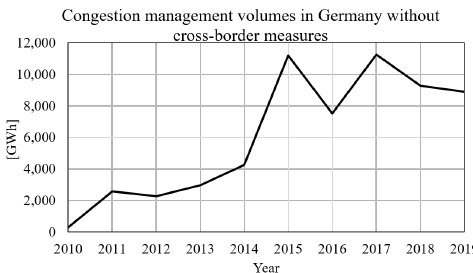
Figure 1. Development of CM volumes in Germany in Gigawatt hours (GWh)